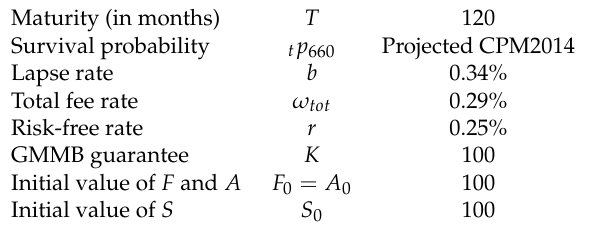
Table A1. Baseline parameters in monthly frequency used in simulations of Sections 4.4 and